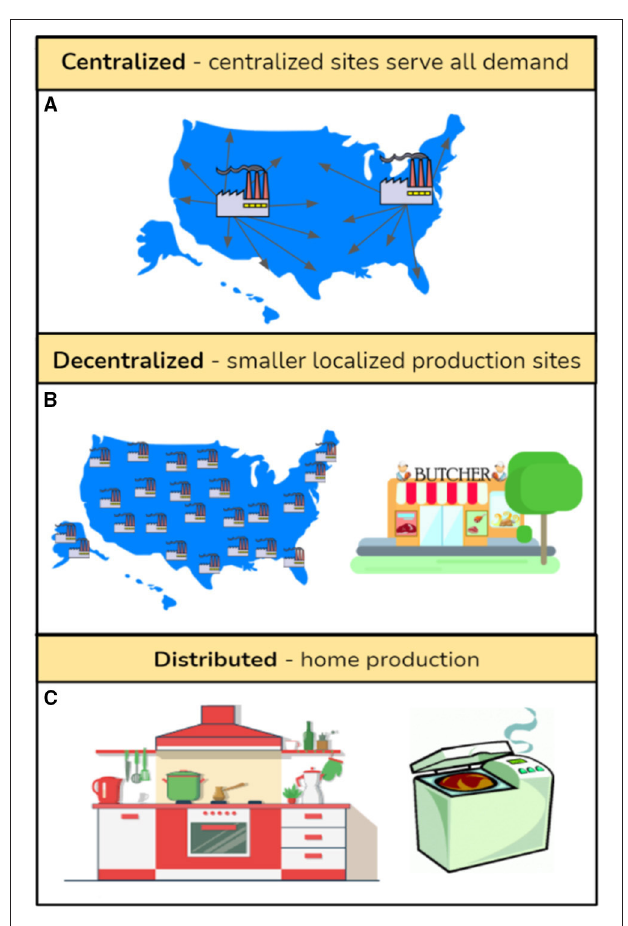
FIGURE 2 | Visual summary of the three supply systems: (A) Centralized, (B) Decentralized, and (C) Distributed Supply Systems.